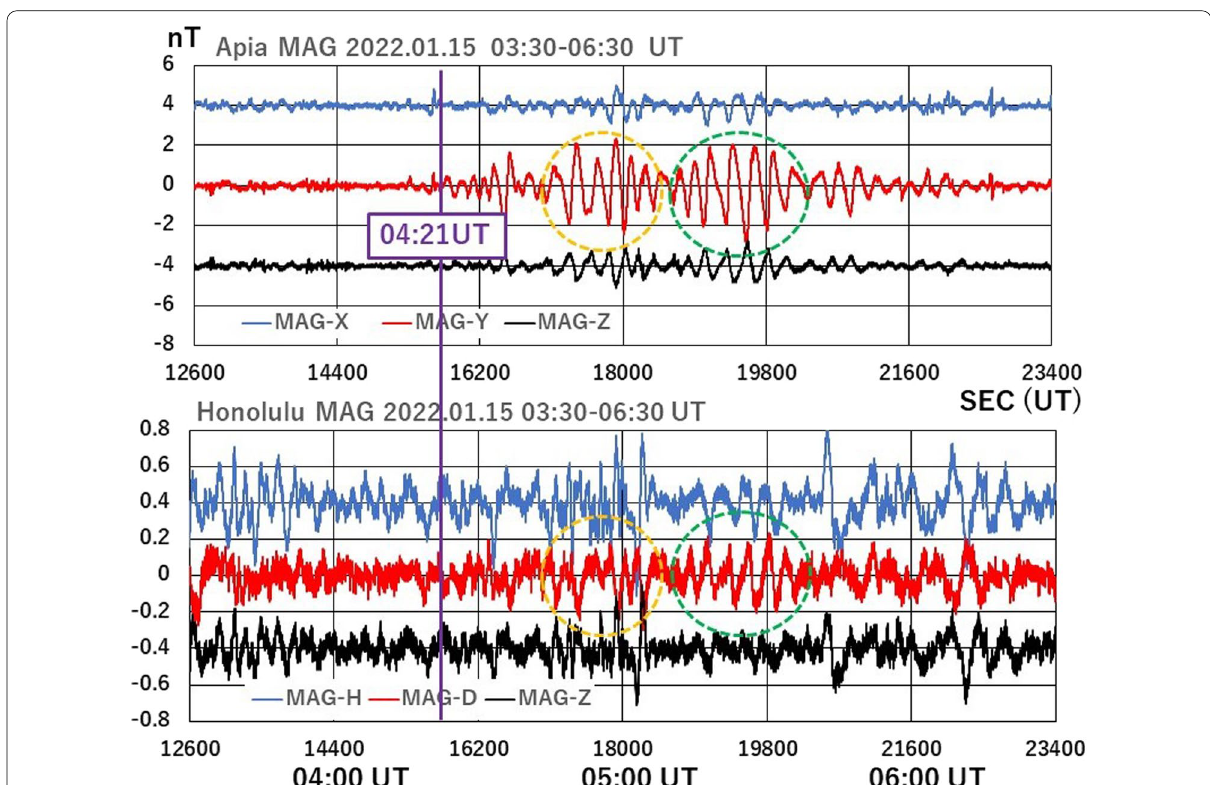
Fig. 2 Enlarged plots of high-pass filtered geomagnetic components. An oscillation at Apia start around 04:21 UT, about 7 min after the start of eruption. Although the amplitude is small, coherent oscillations with those in Apia encircled by orange and green dotted lines are observed at